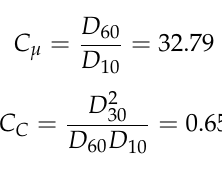
Figure 3. Volcanic ash material sample. 2.3. Hydrated Lime Hydrated lime was procured from a local store near the laboratory. 3. Methods 3.1. Combination Scheme and Sample Preparation Volcanic ash (VA) and black cotton soil (BCS) were air-dried and grounded to pass through 0.75 and 0.5 mm sieving openings. Both VA and BCS were oven-dried for 24 h at 105 °C temperature. The samples were then weighed and thoroughly mixed with different lime, VA and BCS combination dosages, after which they were ready for testing. The de- sign scheme for BCS stabilization is presented in Table 3.